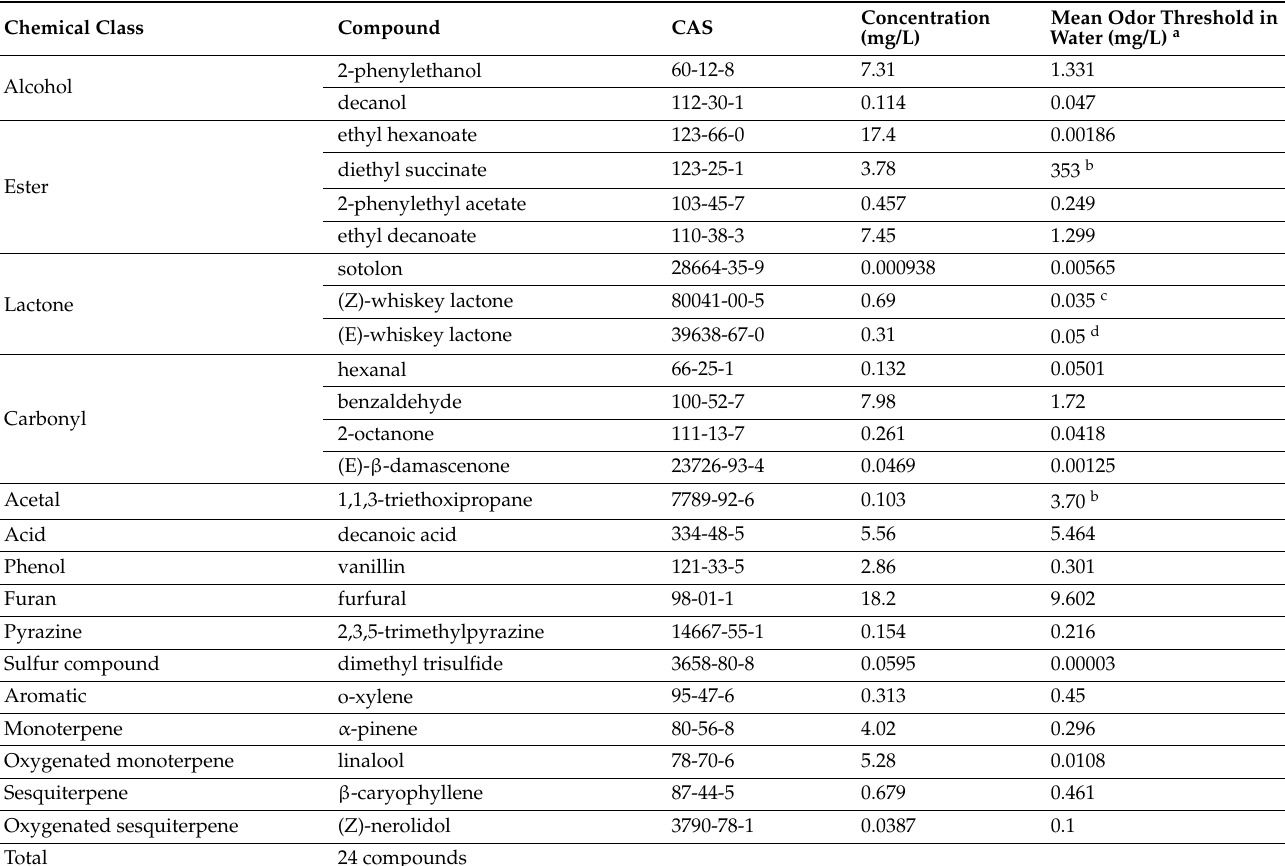
Table 1. Composition of the model